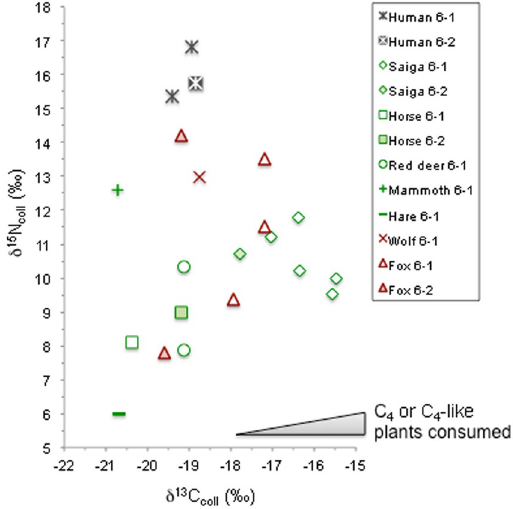
Figure 2. Measured δ 13 C coll and δ 15 N coll values of saiga, horse, red deer, mammoth, hare as herbivores (in green) and wolf, fox and anatomically modern humans from layers 6-1 and 6-2 of Buran-Kaya III (in red).